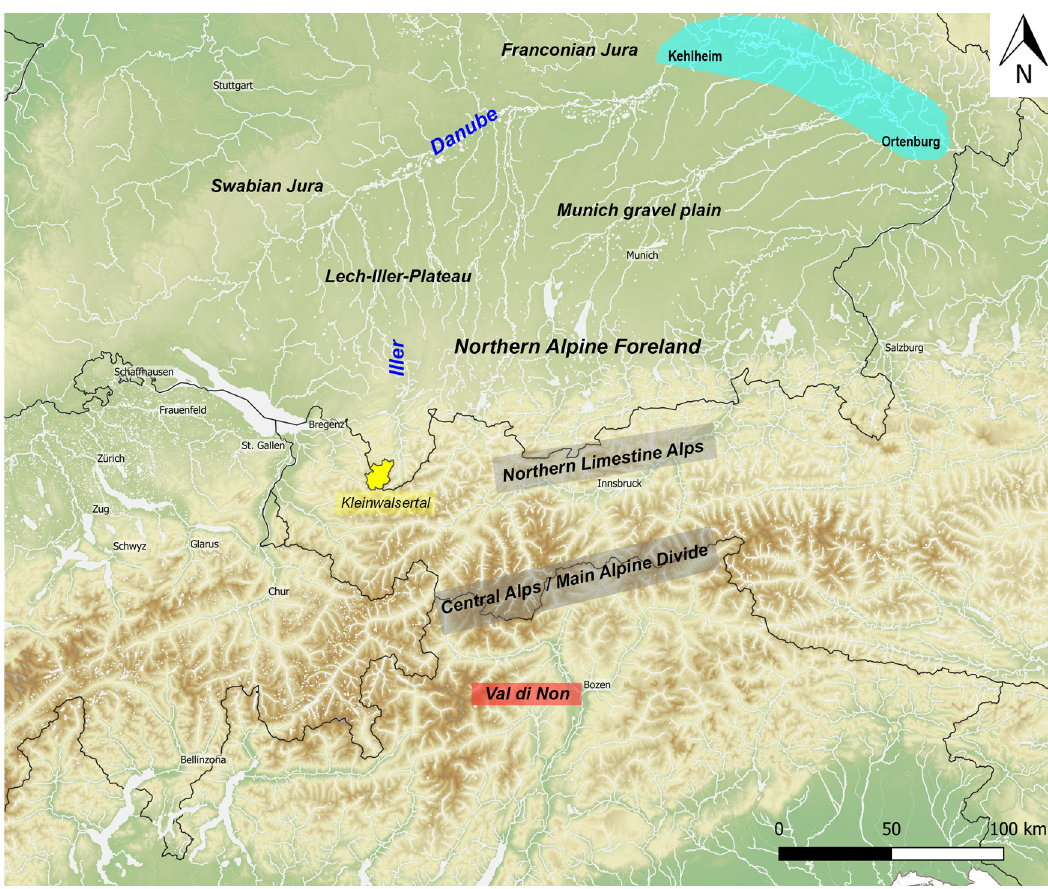
Figure 15: Geographic location of exogenous raw material deposits from the sites Schneiderküren and Egg - Schwarzwasser , as well as site clusters 3 and 4 . In blue: Bavarian Danube basin. In red: Val di Non region. Further chert outcrops can be found within the region of the Franconian and Swabian Jura. Data source: Copernicus eu_dem_v11_E40N20 – 25 m